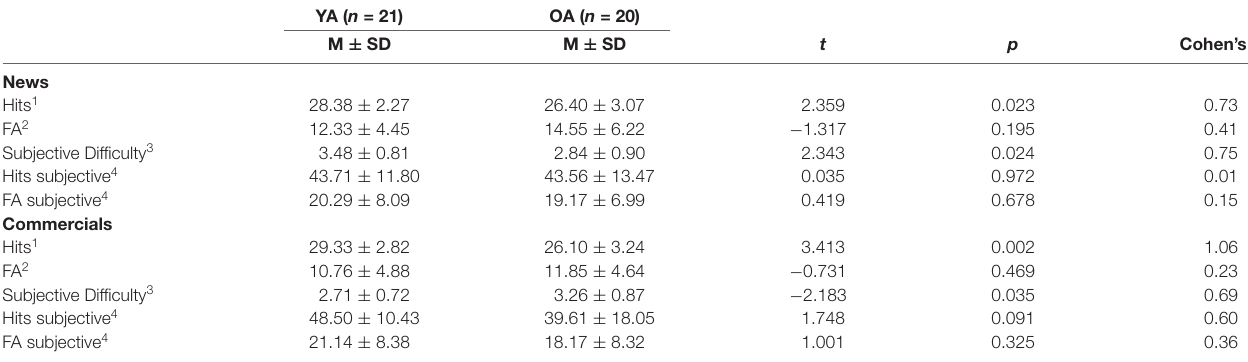
TABLE 4 | Hits and false alarms on watching news and commercials in young adults (YA) and older adults